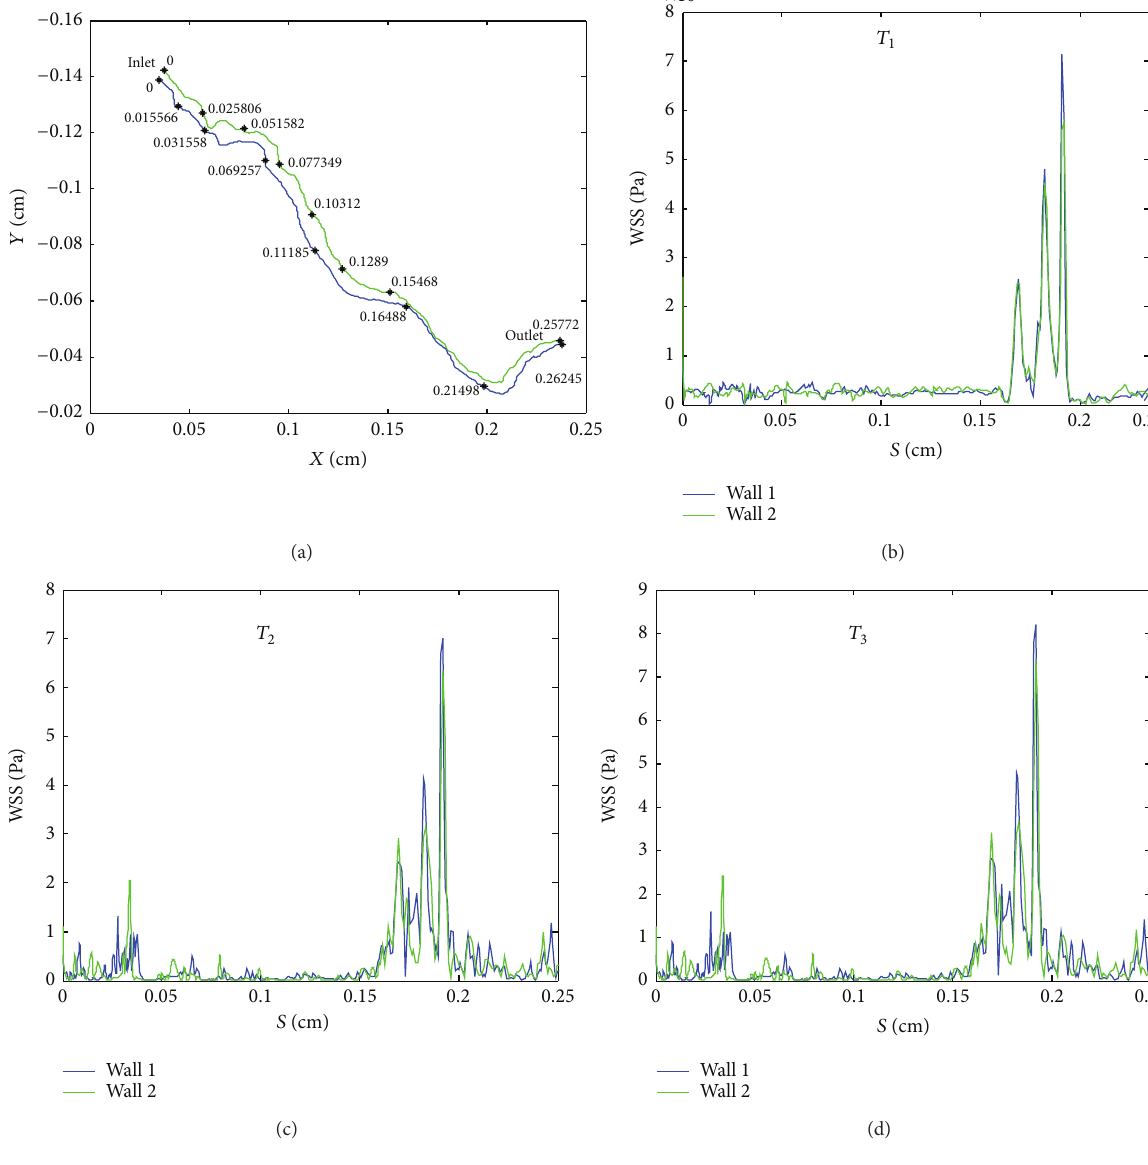
Figure 3: (a) Boundary plots of the coronary arterial walls 1 and 2 shown in green and blue, respectively. (b)–(d) WSS distribution along coronary walls at time 𝑇 1 , 𝑇 2 , and 𝑇 3 ,